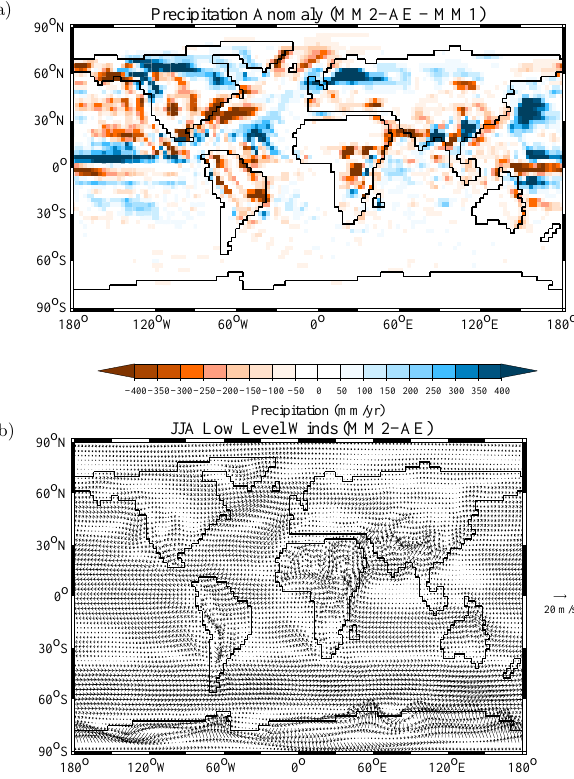
Fig. 14. Same as Fig. 12 for experiment MM2-AE that considers a reduced topography only in North America and in